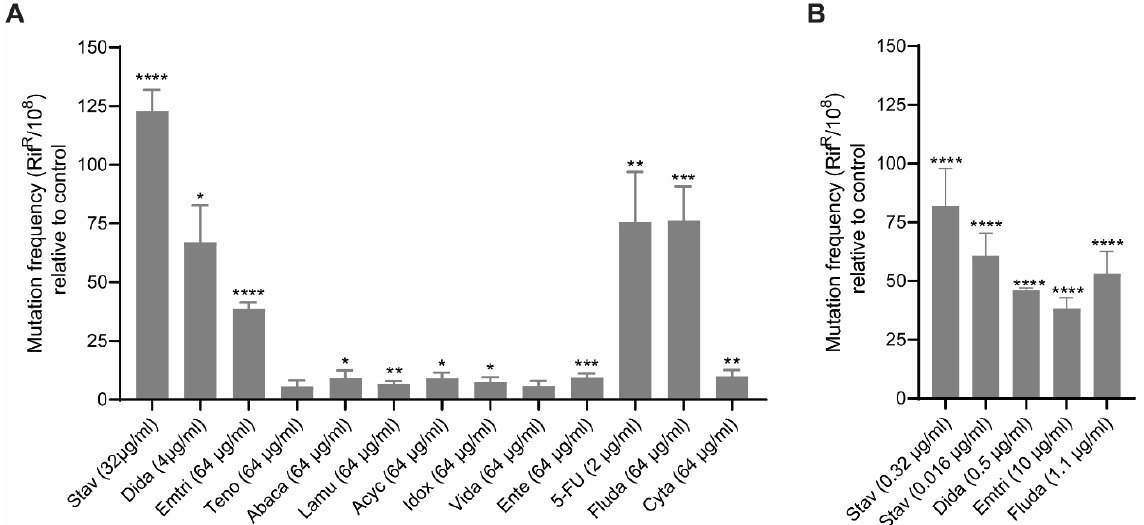
Figure 1. Nucleoside analogues (NAs) induce mutagenesis in Escherichia coli MG1655 . Data represents the average increase in mutation frequency in E. coli MG1655 cells detected in the Rif R assay after treatment, compared to untreated control. ( A ) Mutation frequencies determined using 0.5× MIC or 0.25× of maximal examined concentration (256 μ g/mL) (Table 1) of the different NAs. The relative increase in mutation frequency is given from 5 independent biological replicas. Stavudine (Stav, 32 μ g/mL), didanosine (Dida, 4 μ g/mL), emitrcitabine (Emtri, 64 μ g/mL), tenofovir (Teno, 64 μ g/mL), abacavir (Abaca, 64 μ g/mL), lamuvudine (Lamu, 64 μ g/mL, acyclovir (Acyc, 64 μ g/mL), idocuridine (Idox, 64 μ g/mL), vidarabine (Vida, 64 μ g/mL), entecavir (Ente, 64 μ g/mL), 5-fluro uracil (5-FU, 2 μ g/mL), fludarabine, (Fluda, 64 μ g/mL) and cytarabine (Cyta, 64 μ g/mL). ( B ) Mutation frequency at plasma concentrations of Stav (0.32 μ g/mL and 0.016 μ g/mL), Dida (0.5 μ g/mL), Emtri (10 μ g/mL) and Fluda (1.1 μ g/mL). The relative increase in mutation frequency is given from a minimum of 3 independent biological replicas, except for 0.32 μ g/mL Stav, which are from 14 independent biological replicas. Each biological replica consists of 2–3 technical replicates. Unpaired Student’s t-test, two-tailed, **** p < 0.0001, *** p < 0.001, ** p < 0.01 and * p < 0.05.